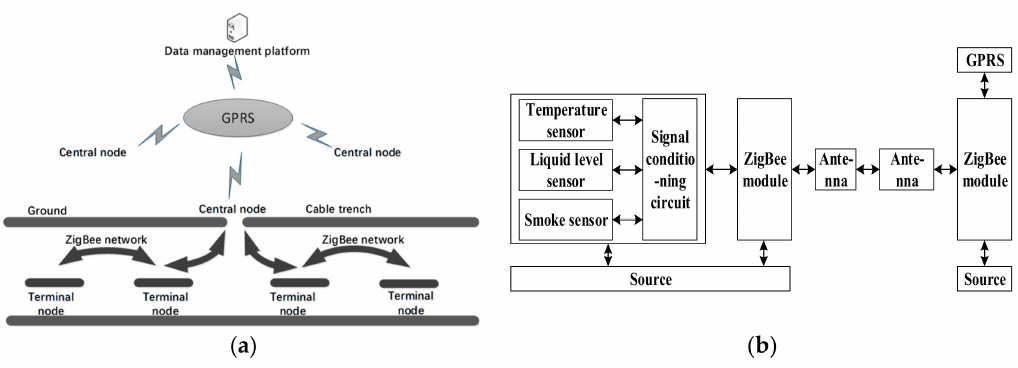
Figure 10. Overall scheme and function module of online monitoring system. ( a ) Scheme and data flow chart. ( b ) Functional modules and